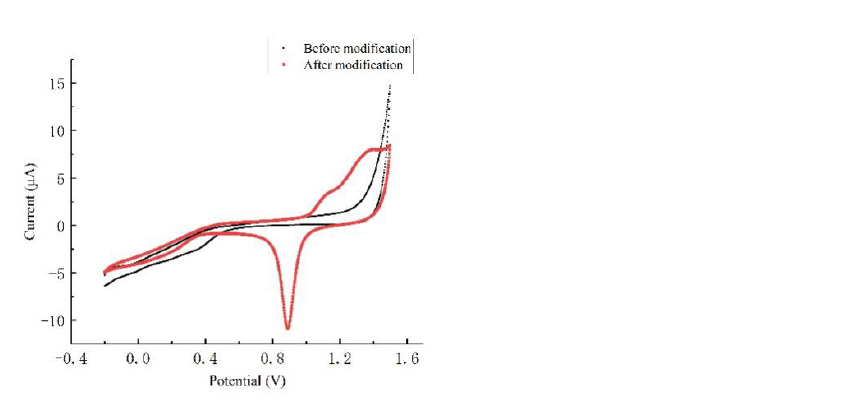
Figure 6. CV characteristic curve of the ultramicro electrode in K 3 [Fe(CN) 6 ], before and after modi- fication. 3.2. Optimization of Detection Parameters In the enrichment stage, a constant negative voltage is applied to the working elec- trode and the heavy-metal ions could be reduced and deposited on the surface of the working electrode. Therefore, it is necessary to optimize the parameters related to the enrichment process for the detection. In the sample with a copper ion concentration of